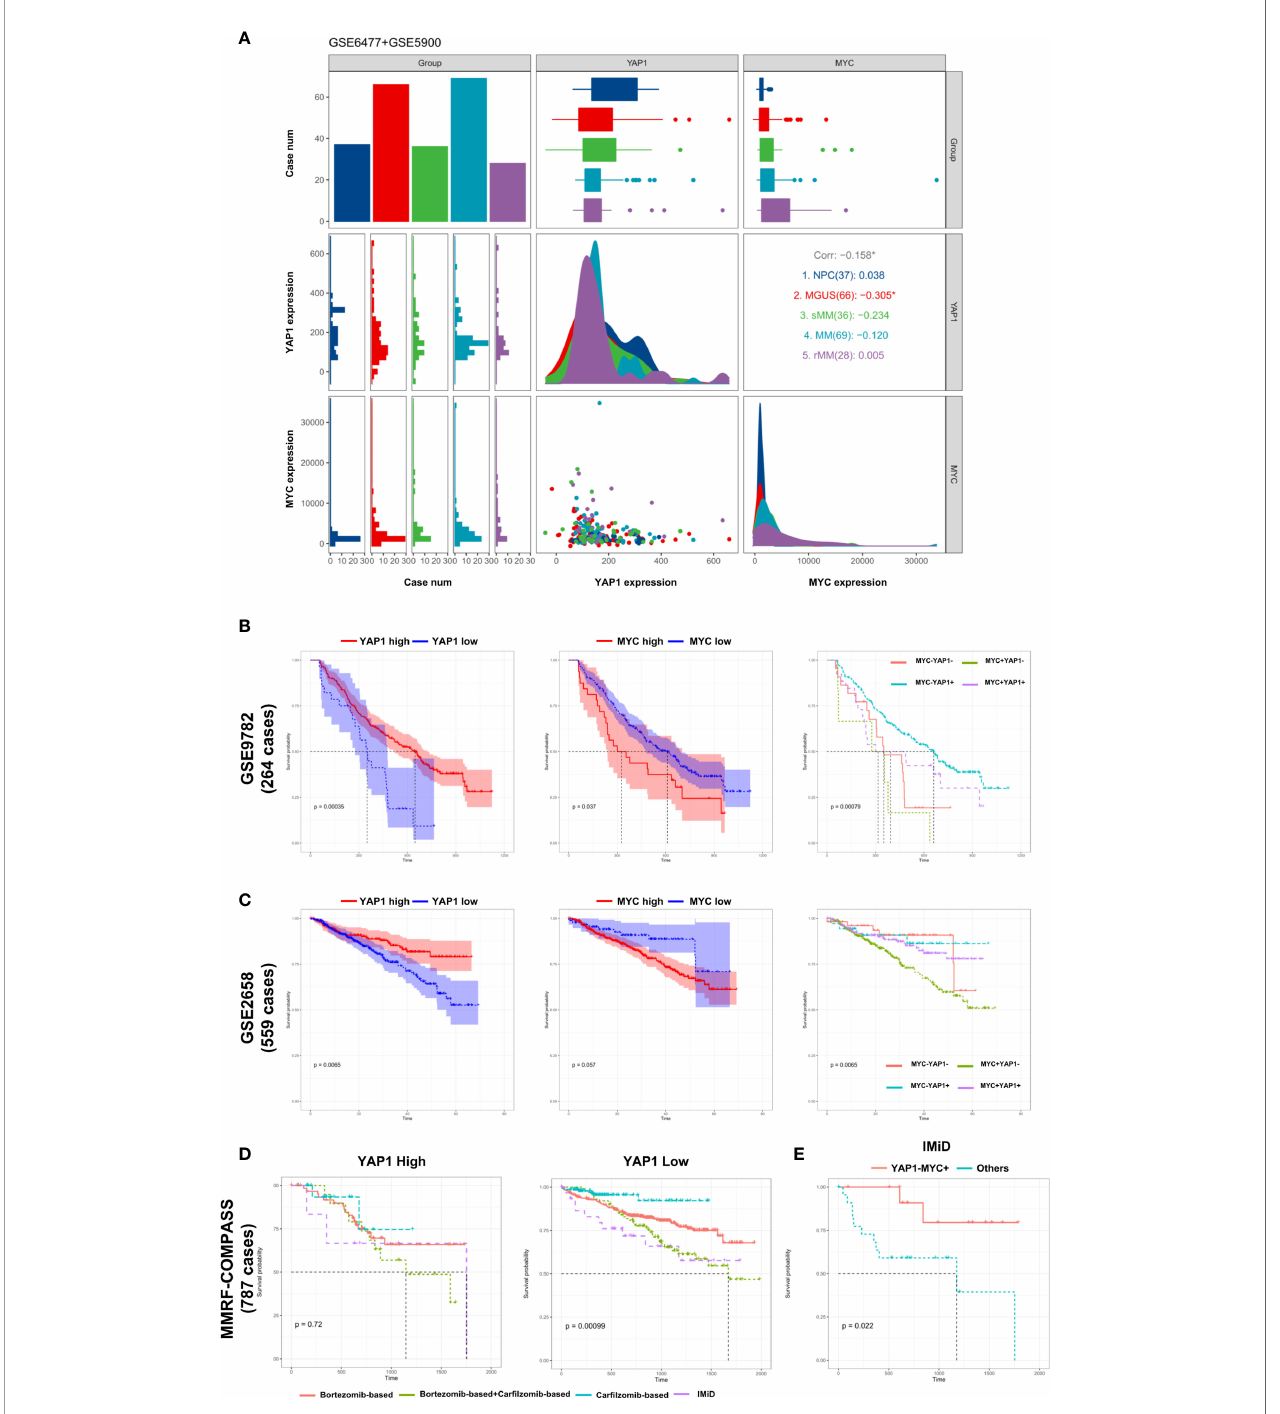
FIGURE 3 | External validation of the prognostic signi fi cance of YAP1/MYC and their impact in MM therapies. (A) The comparison of YAP1/MYC mRNA expression levels in different developmental stages of MM. The x- axis represents case number/YAP1 count value/MYC count value from left to right while the y -axis represents case number/YAP1 count value/MYC count value from top to bottom. NPC: normal plasma cell; MGUS: monoclonal gammopathy of undetermined signi fi cance; sMM: smothering multiple myeloma; rMM: relapsed multiple myeloma. (B) Kaplan – Meier survival curves comparing the overall survival in MM cases with differential expression level of YAP1 and MYC in GSE9782 dataset (264 cases). (C) Kaplan – Meier survival curves comparing the overall survival in MM cases with differential expression level of YAP1 and MYC in the GSE2658 dataset (559 cases). (D) The survival rate of MM patients with high or low expression of YAP1 treated with different strategies. (E) The survival rate of YAP1-MYC+ MM patients versus others treated with